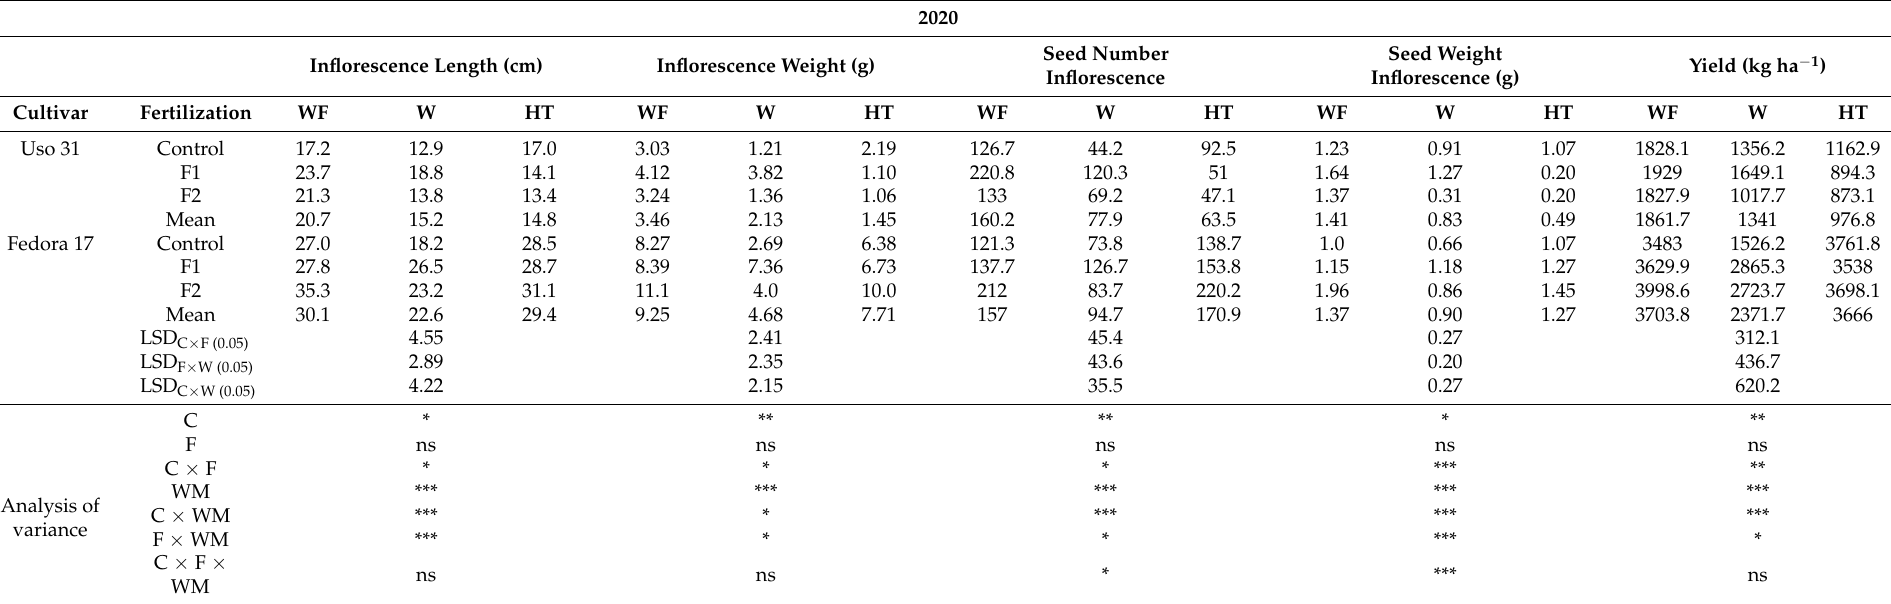
Table 2. The effects of the experimental factors on the average values and the analysis of yield and yield components of hemp in the 2020 growing season. WM: weed management treatments (WF: weed-free; W: weedy; HT: herbicide treatment); C: cultivars; F: fertilization treatments (Control: without fertilization; F1: 70 kg ha − 1 ; F2: 140 kg ha − 1